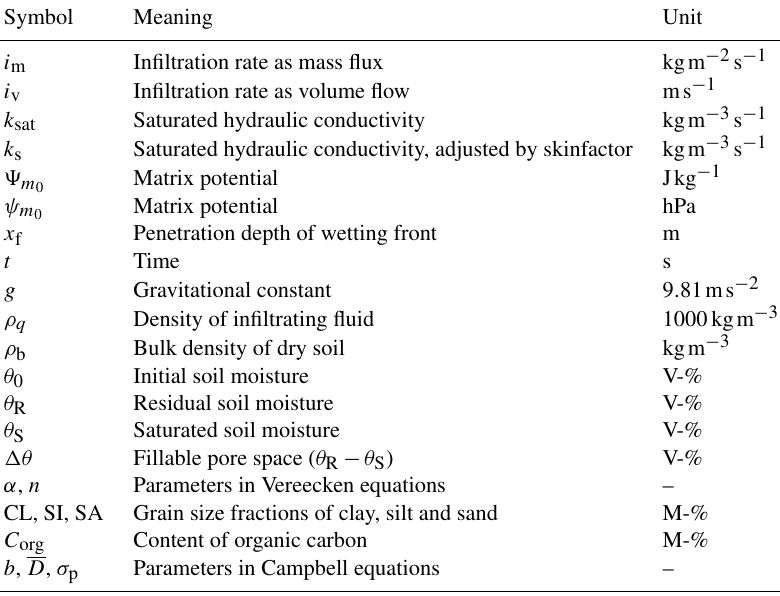
Table 1. List of symbols used in infiltration model equations.